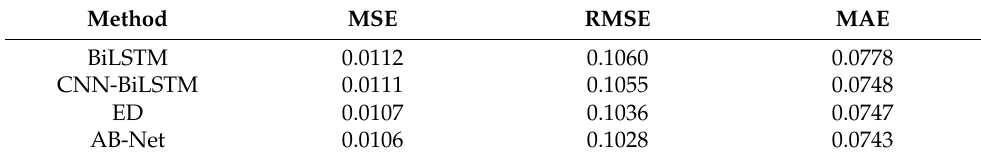
Table 2. Results obtained for different models on solar data via ablation